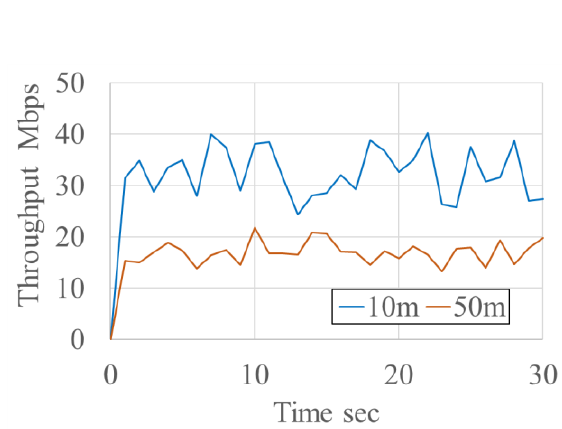
Figure 10. Temporal evolution of TCP throughput in each communication distance (the sender is controller): The blue line is the 10 m results, and the orange line is the 50 m results.